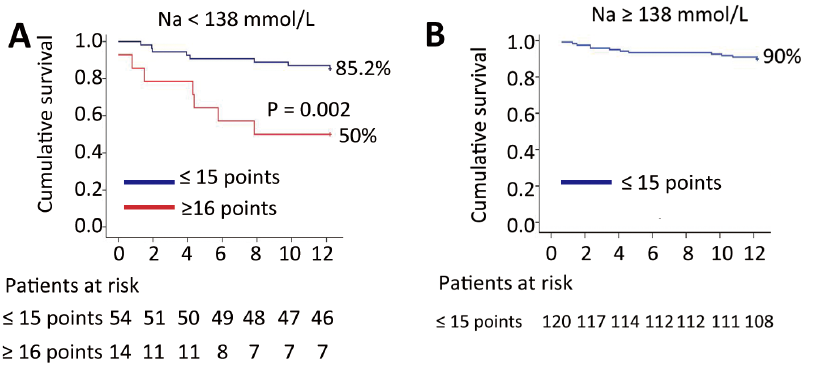
Figure 3. Subgroup analysis of one-year cumulative survival in patients pooled from the training cohort and validation cohort undergoing TIPS with variceal bleeding.